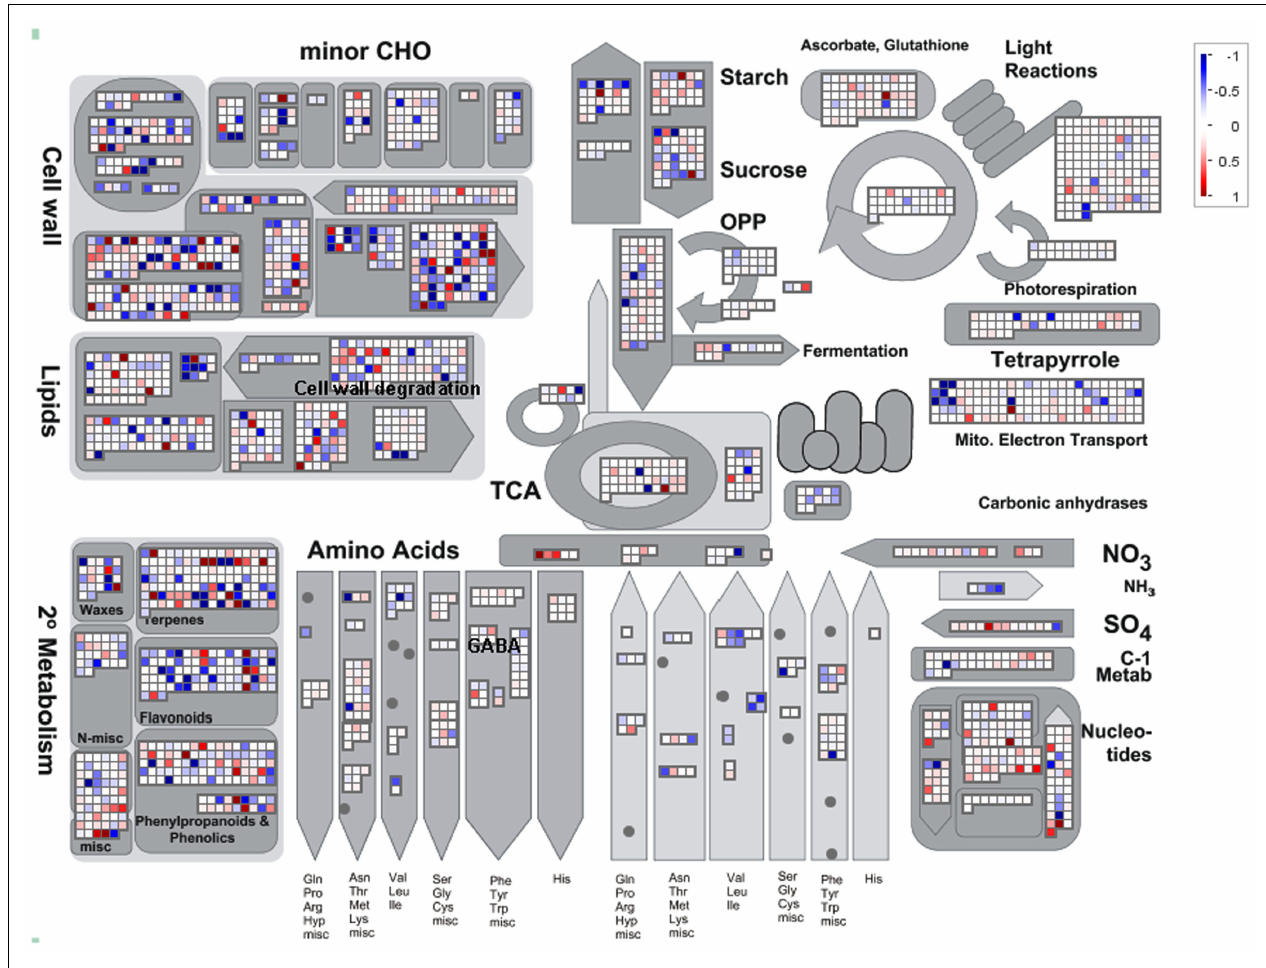
SP-treated samples with respect to the control samples.The color scale used is reproduced in the Figure. Fully expanded leaves of 4-week-old plants were harvested at the middle of the light period, washed three times with 10mM MES-KOH (pH 6.5), and then incubated in presence or absence of 100 μ M of